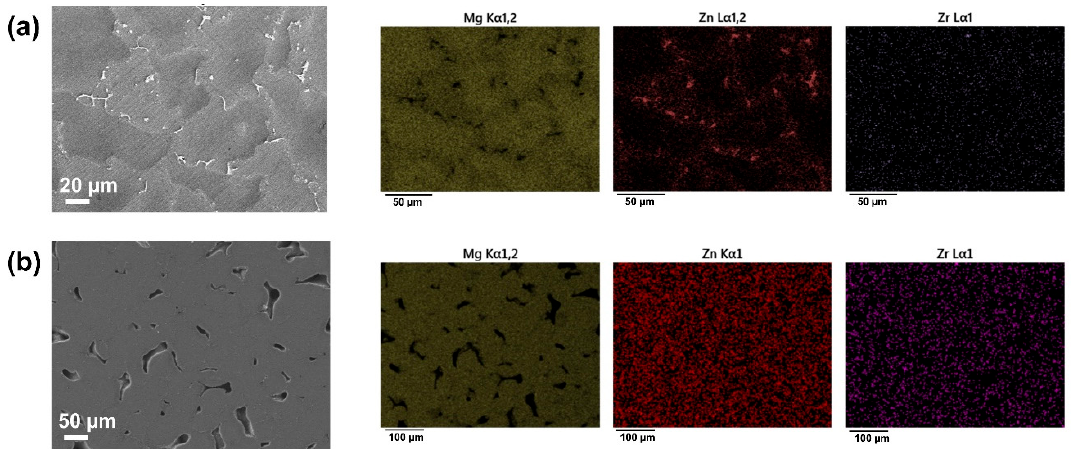
Figure 2. SEM micrographs and EDX elemental mappings for the samples, ( a ) dense and ( b ) porous Mg-Zn-Zr scaffold. Table 1. Chemical composition of dense and porous Mg-Zn-Zr samples as determined from